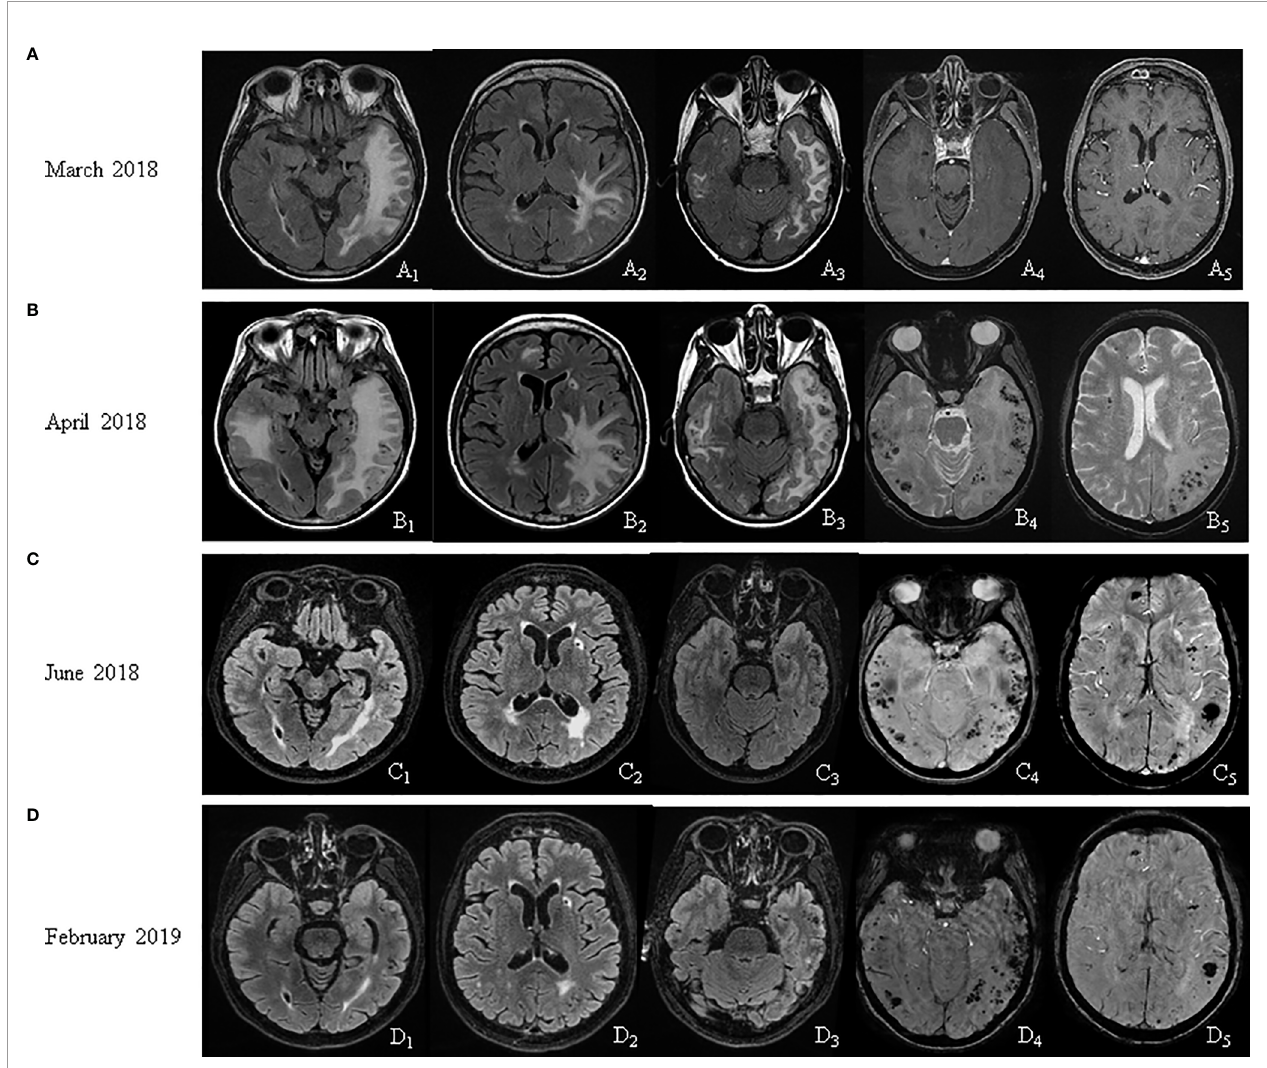
FIGURE 1 | MRI follow up. (A) March 2018: FLAIR sequences showed a left temporo-parieto-occipital and a right temporal hyperintensity (A1, A2, A3); no gadolinium enhancement (A4, A5). (B) April 2018: FLAIR sequences showed an extension of the white matter (WM) hyperintensity (B1, B2, B3); gradient-echo sequences showed microbleeds (B4, B5). (C) June 2018: FLAIR sequences showed a reduction of the WM alterations (C1, C2, C3); susceptibility-weighted imaging (SWI) sequences con fi rmed microbleeds (C4, C5). (D) February 2019: FLAIR sequences showed a further reduction of the WM alterations (D1, D2, D3); SWI sequences corroborated microbleeds (D4,